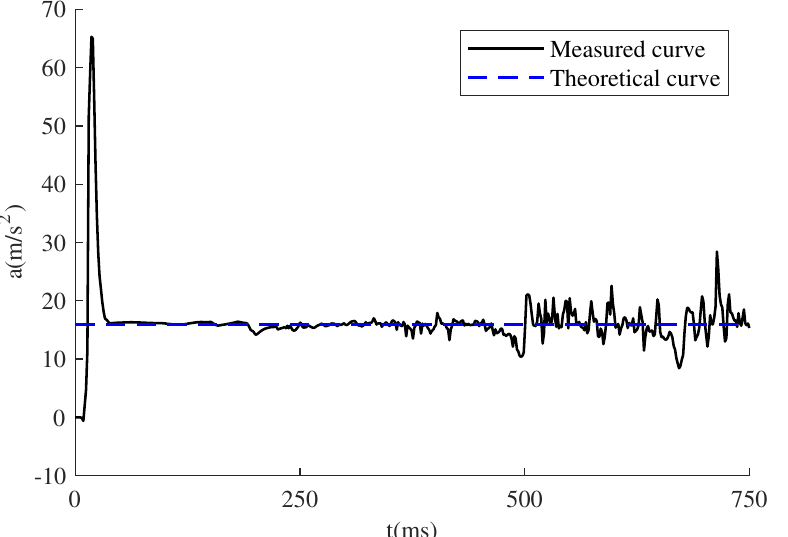
Figure 9. Acceleration–time curve of the critical slip state.